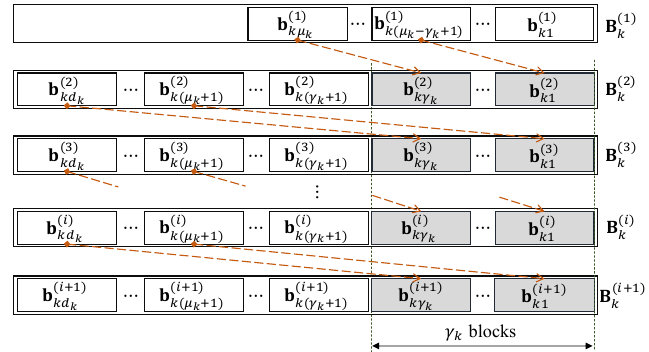
Figure 6. Applied overlapping fashion of overlapped chunked codes (OCC) for source k . The blocks in grey for chunk i are the blocks taken from the previous chunk, i.e., chunk i −